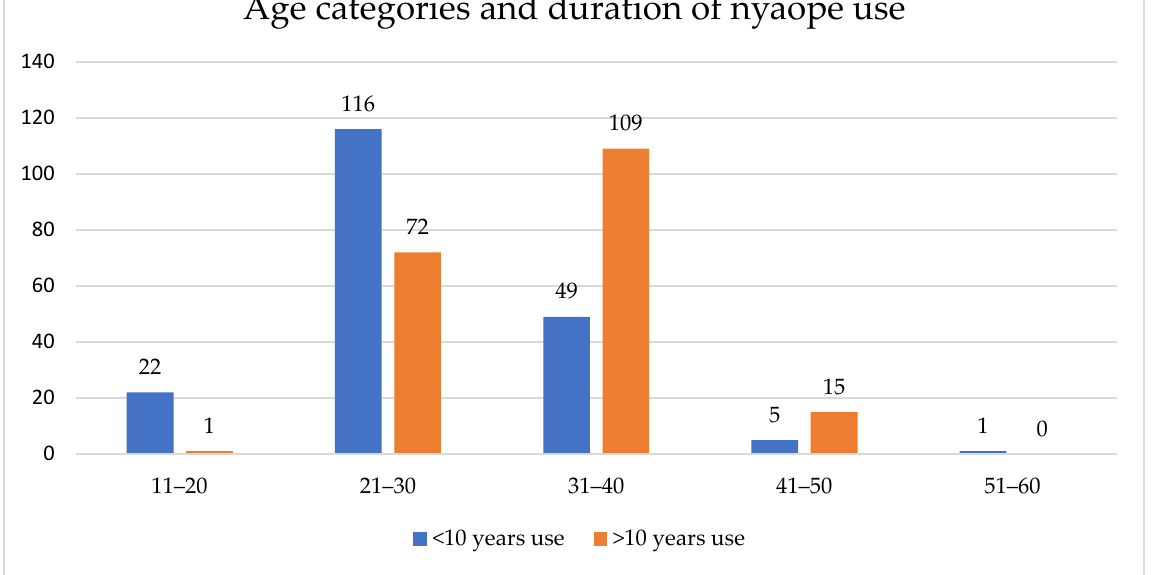
Table 4. Screening results for depression symptoms using PHQ-9. PHQ-9 Ranges